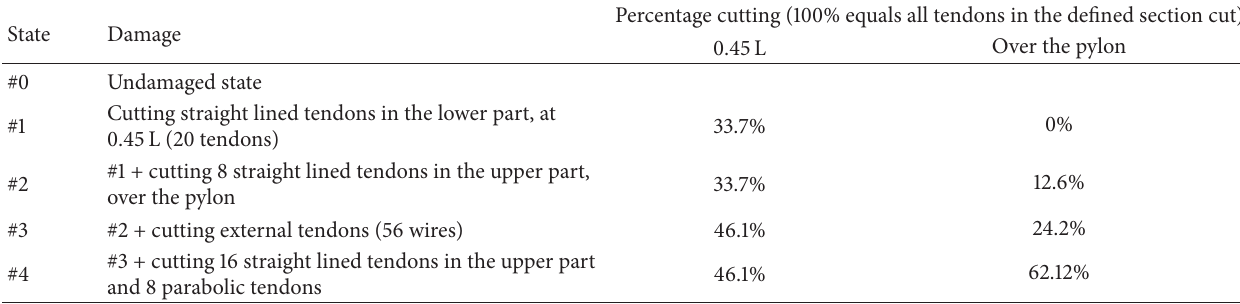
Table 1: Description of the damage scenarios according to the cutting sections shown in Figure